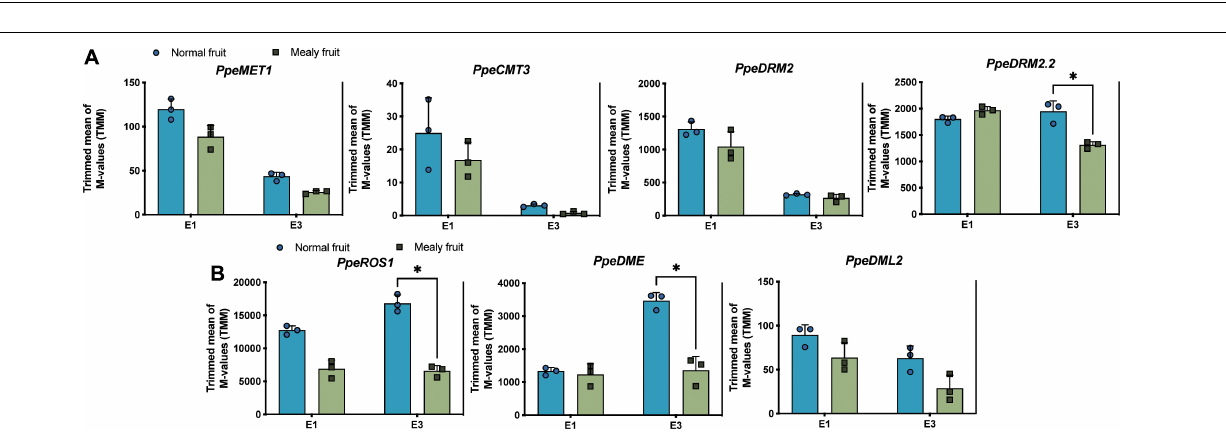
FIGURE 6 | Differentially expressed genes between normal and mealy fruits associated with changes in DNA methylation. (A) Expression levels of DEGs overlapping with DMRs between normal and mealy fruits at E1. DEGs are grouped as hypermethylated and hypomethylated. (B) Cytosine methylation level of a hypermethylated region in mealy fruits compared to normal fruits. The DMR of approximately 2.500 bp is located within the coding region of a CYP450 82A3 (Prupe.3G066200) gene. Color key indicates methylation levels where green represents high levels and red, low levels. (C) Expression levels of DEGs overlapping with hypermethylated regions between normal and mealy fruits at E3. (D) DNA methylation level of a hypermethylated region in mealy fruits compared to normal fruits. The DMR of approximately 120 bp is located in the promoter region of an UDP-ARABINOSE 4-EPIMERASE1 (Prupe.3G187800) gene.